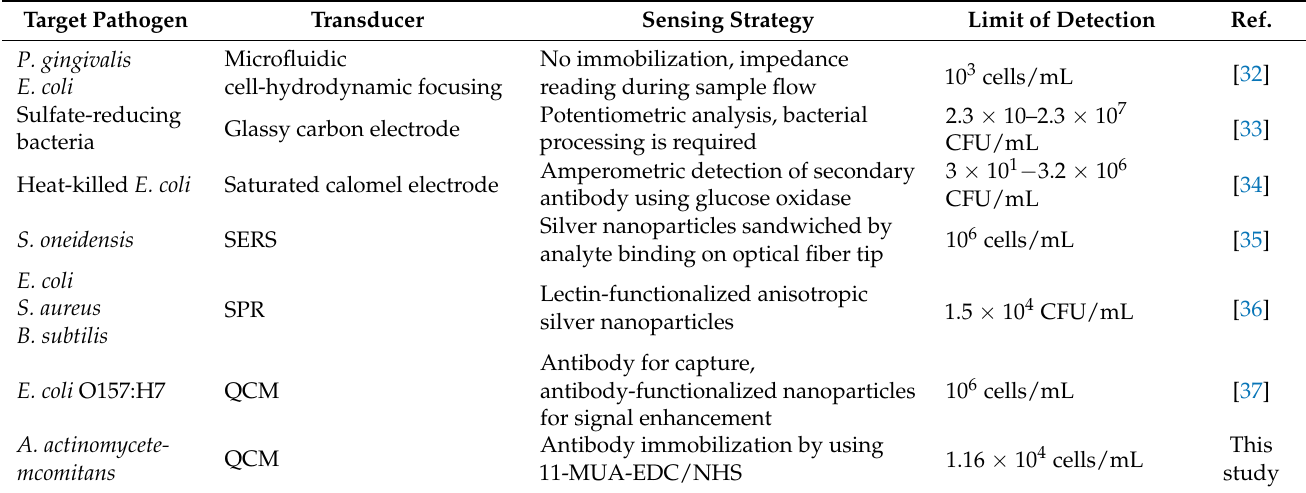
Table 3. Performance of the different biosensor types for bacterial